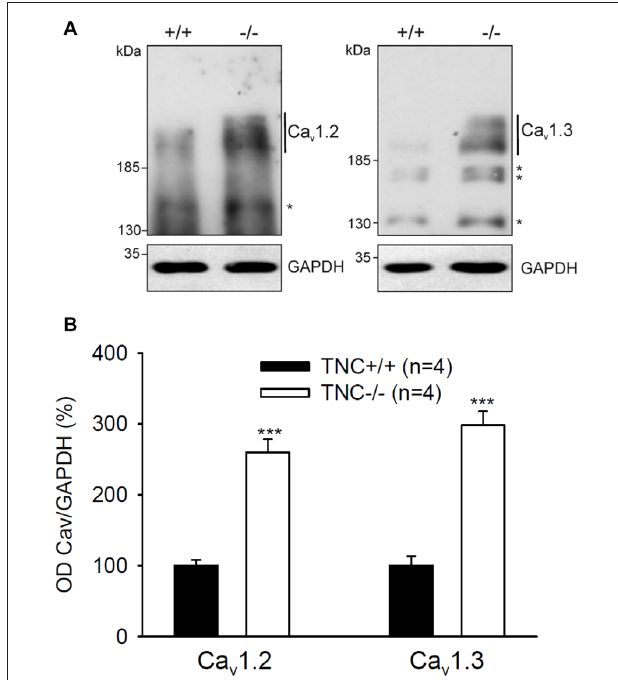
FIGURE 3 | Elevated expression of L-VGCCs in hippocampus of TNC − / − mice. Homogenates of hippocampi from TNC − / − and TNC + / + littermates were subjected to Western blot analysis using antibodies against the Ca v 1.2 and Ca v 1.3 subunits of L-VGCCs and against glyceraldehyde-3- phosphate dehydrogenase (GAPDH) to control loading. (A) Representative Western blots are shown. (B) The amounts of Ca v 1.2 and Ca v 1.3 ranging from ∼ 190 kDa to ∼ 220 kDa (indicated by vertical lines) were determined by densitometry and normalized to GAPDH levels. The asterisks in (A) indicate bands of unknown identity. Means and SEMs of the expression levels (4 animals for each genotype) were related to the mean value measured for TNC + / + hippocampi, which was set to 100%, ∗∗∗ p < 0.001, t